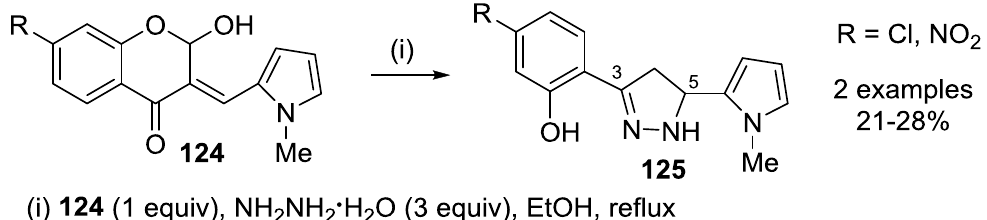
Scheme 42. Synthesis of 3-(2-hydroxyphenyl)-5-(1-methylpyrrol-3-yl)-2-pyrazolines 125 from the reaction of ( E )-2-hydroxy-3-(1-methylpyrrol-2-ylmethylene)chromanones 124 with hydrazine hydrate in refluxing ethanol [86].